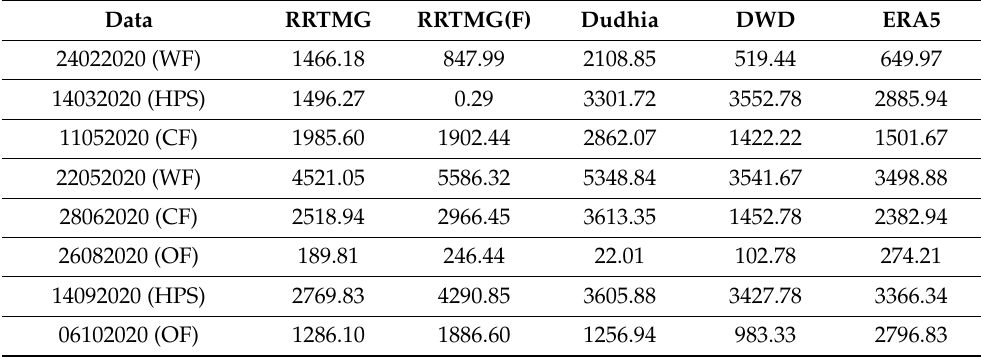
Table 13. Summary of daily values of direct radiation at Arkona station [W · m − 2